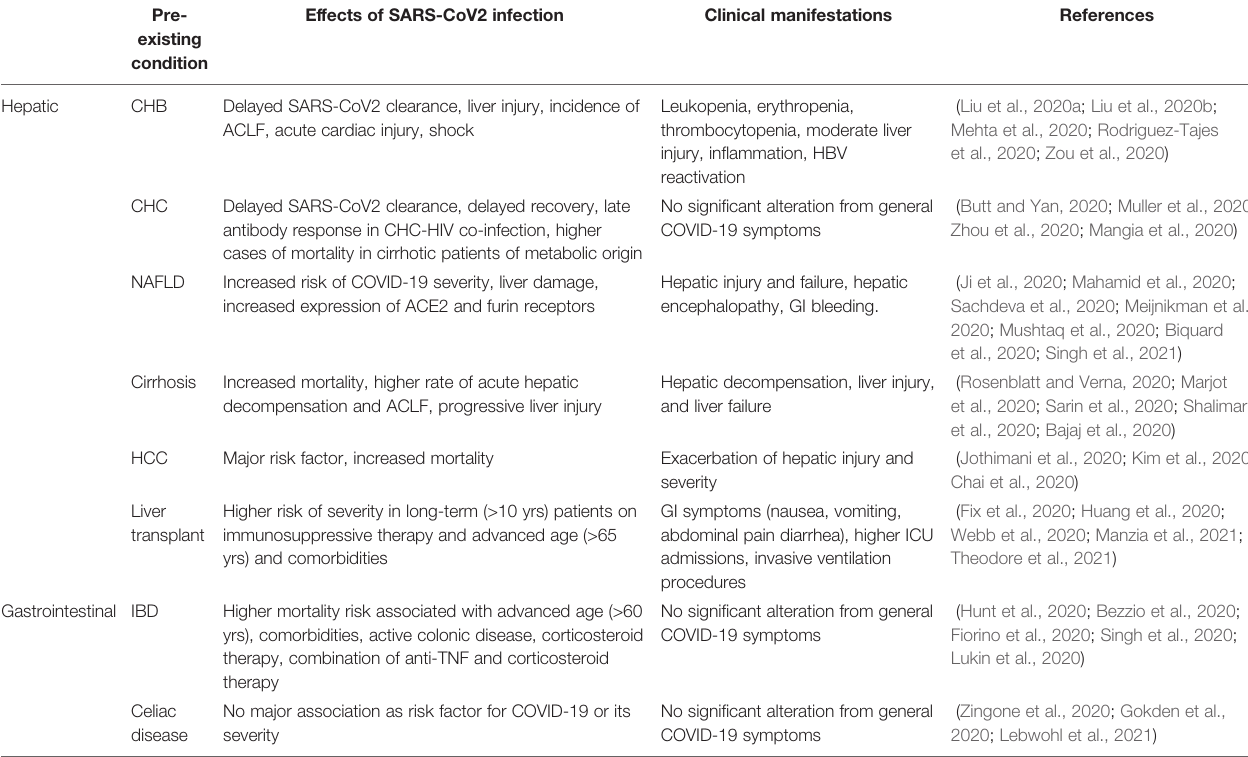
TABLE 1 | Effects of SARS-CoV2 infection on pre-existing hepatic and gastrointestinal